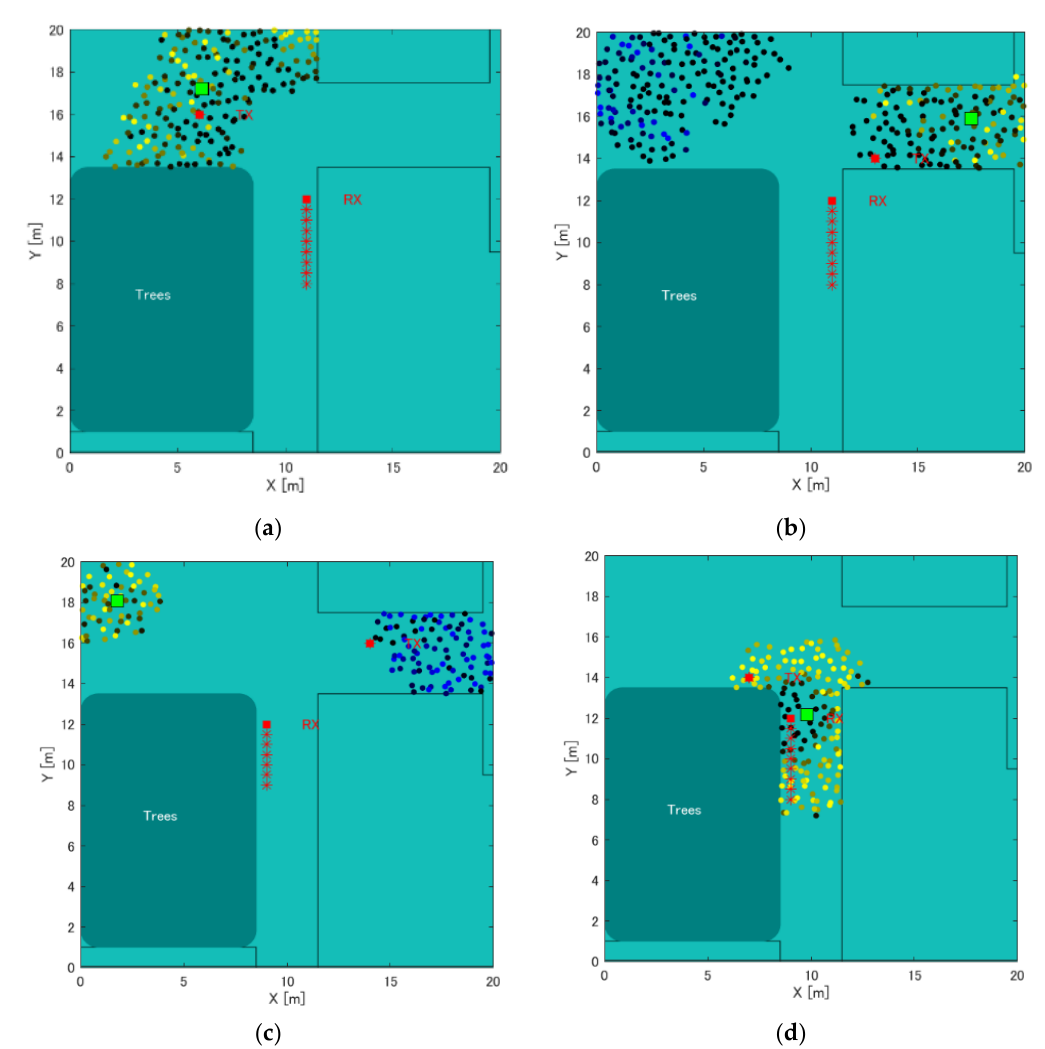
Figure 16. Comparison of the error average of distances in the position estimation result on T-shape road. ( a ) Tx on the left (Tx Point number 2), when Rx moves to the right side of the road by the wall, ( b ) Tx on the right (Tx Point number 16), when Rx moves to the left side of the road, ( c ) Tx on the right (Tx Point number 10), when Rx moves to the left side of the road, ( d ) Tx on the left (Tx Point number 9), when Rx moves to the right side of the road by the wall. Table 1. Position estimation error results of actual measurement on the T-shape road (direction of Tx as seen from Rx is left: Tx Point 1~9, direction of Tx as seen from Rx is right: Tx Point 10~18). Left side of the Right side of the Moved area of Rx Middle of the road road road